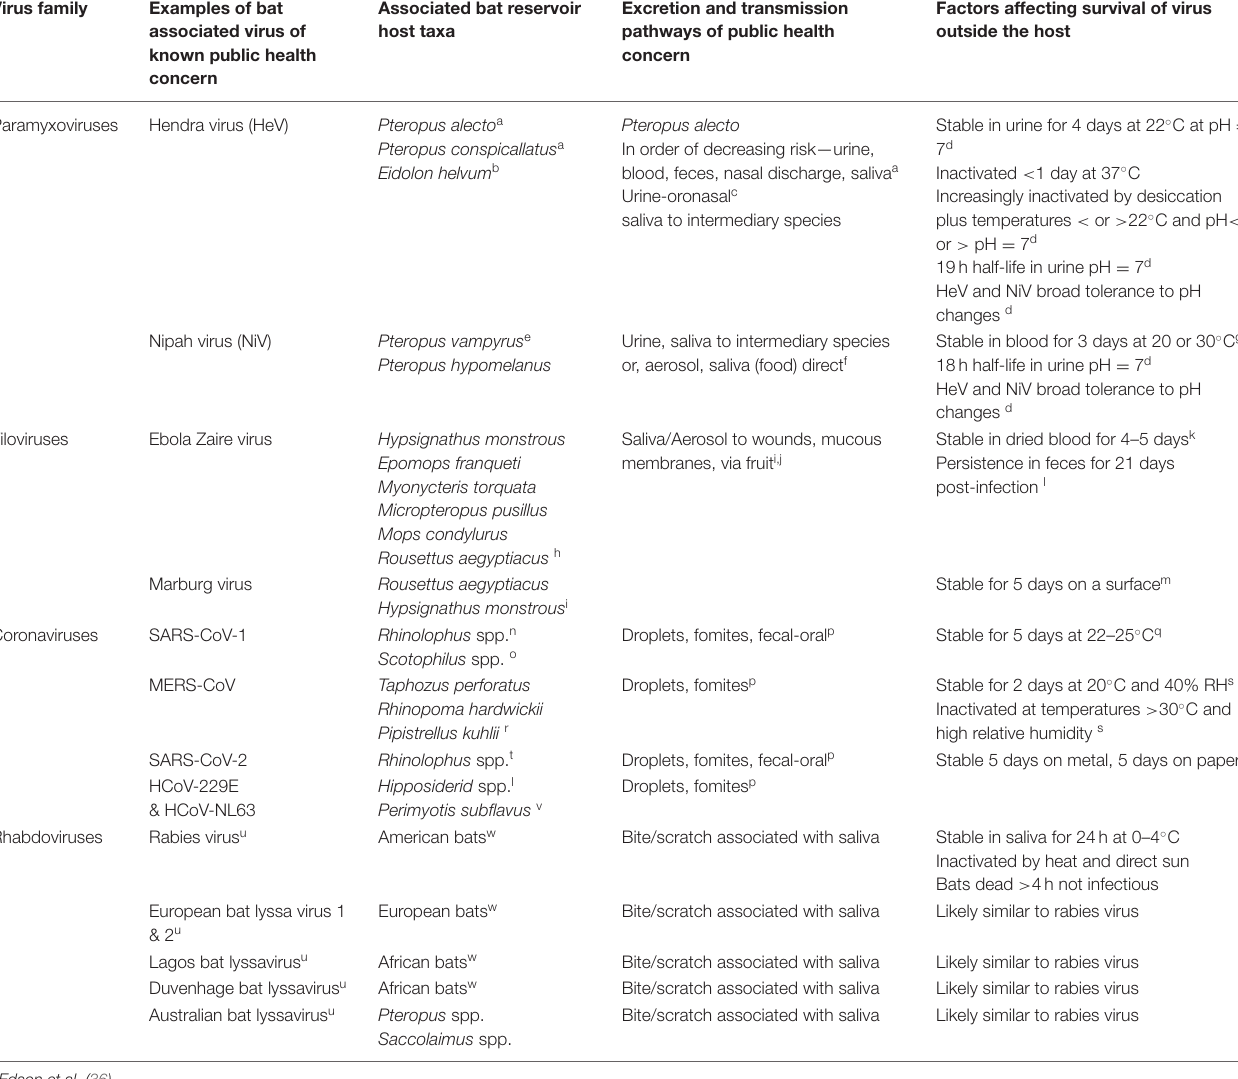
TABLE 4 | Examples of bat associated viruses of public health concern, their hosts, excretion pathways, and factors affecting the virus’s survival. Virus